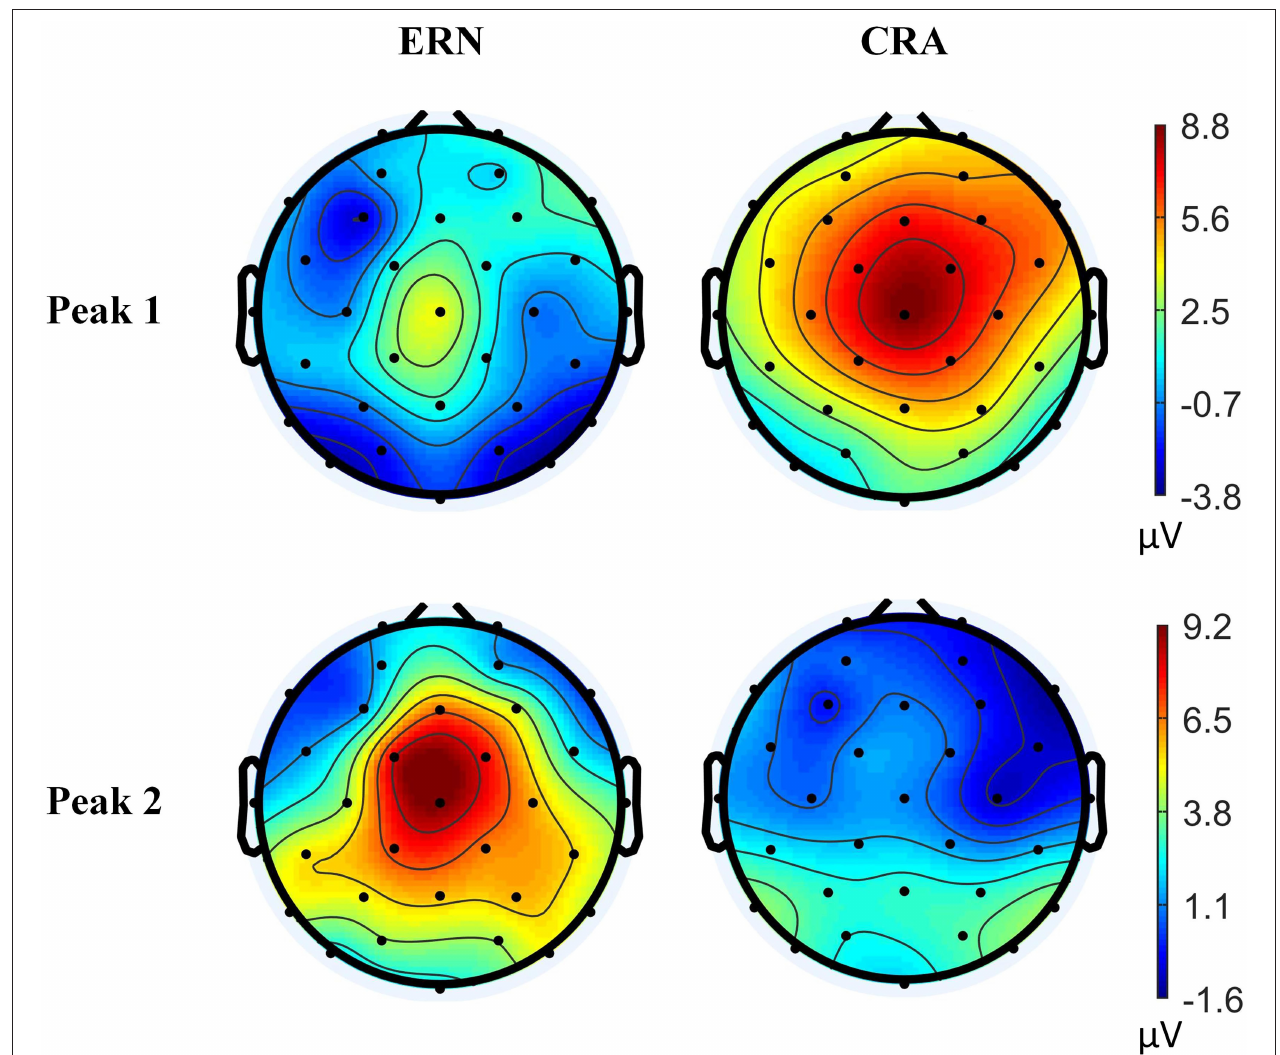
FIGURE 6 | Topographical scalp maps of the grand-average error-related negativity and correct-related activity signals at two time-points, where the Training-ErrP signal was observed to be